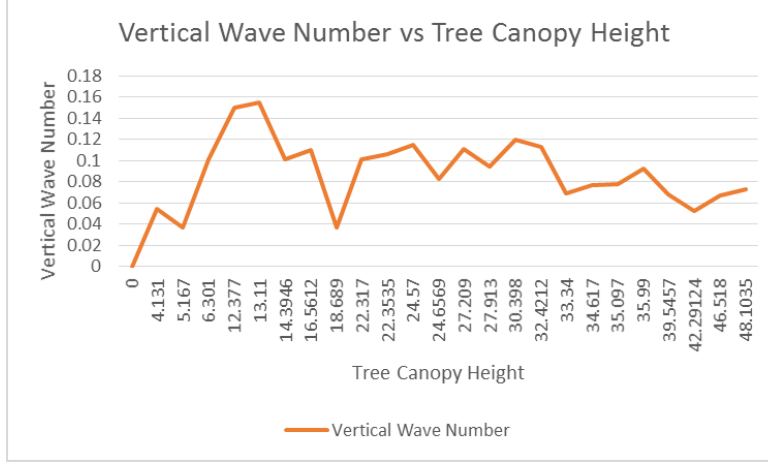
Figure 8. Vertical wave number vs tree canopy height